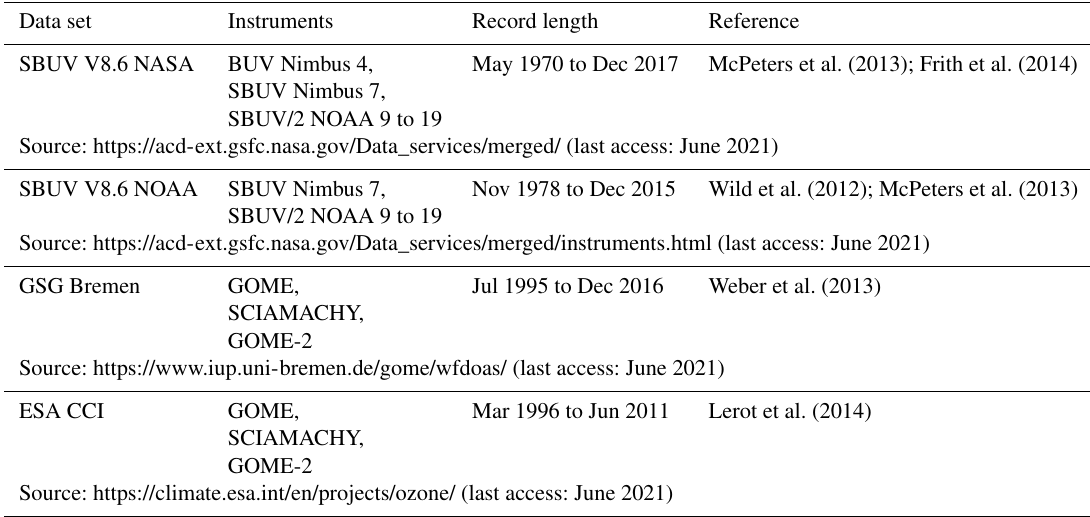
Table 3. Sources and details of the independent data sets used to validate the NIWA-BS total column ozone